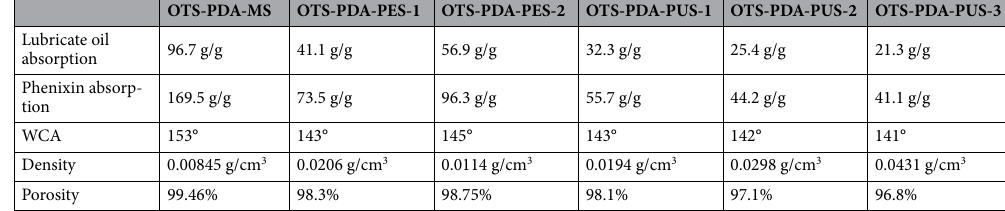
Table 3. Comparison of different types of sponges . modified by PDA and